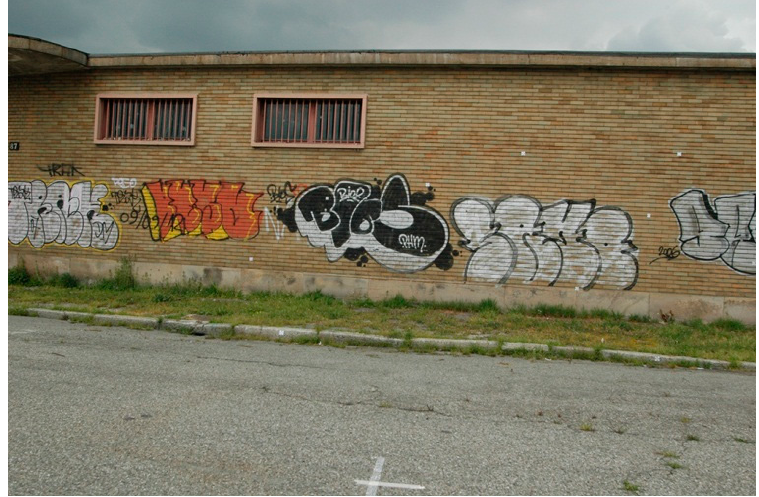
Figure 5. Example of image used for the geometric calibration. The (white) targets are visible on the wall and on the rise of the sidewalk.